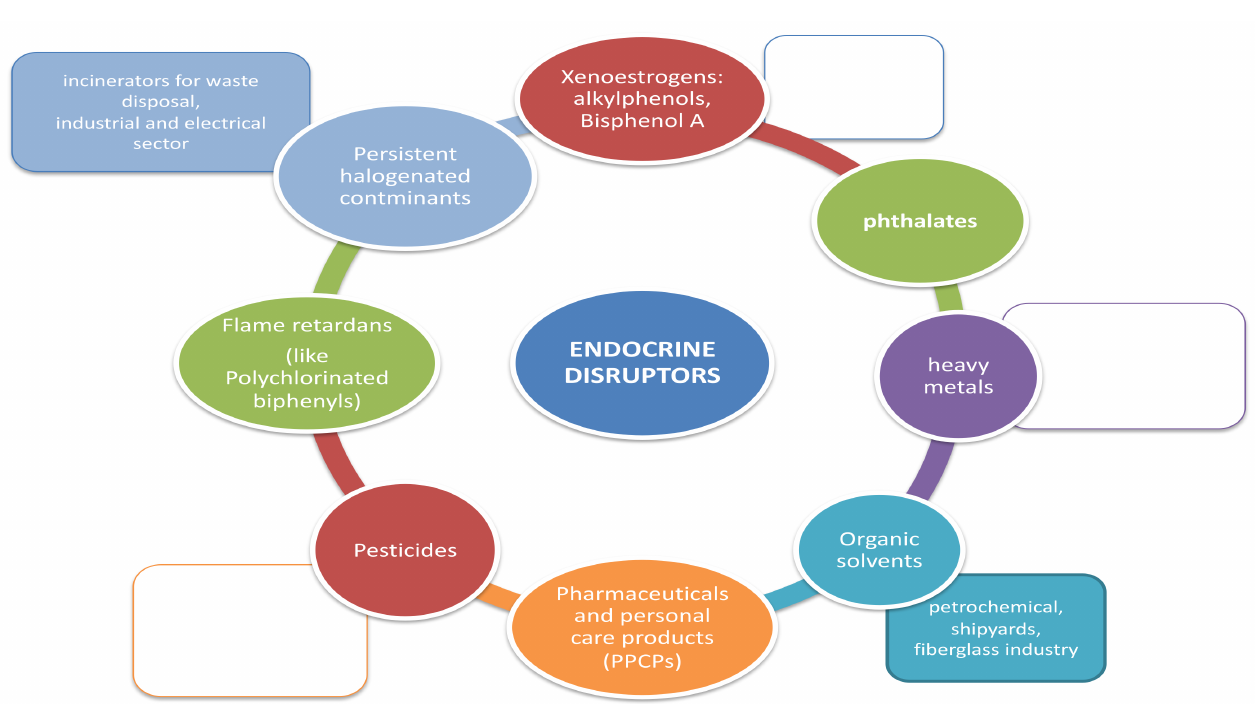
Figure 1. Environmental distribution of endocrine-disruptor chemicals